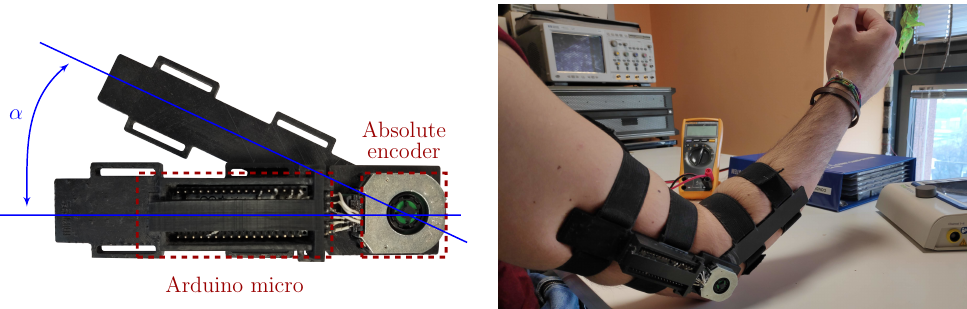
Figure 3. Wearable electro-goniometer developed to test the system performance and to provide an angular feedback on the ongoing stimulation.